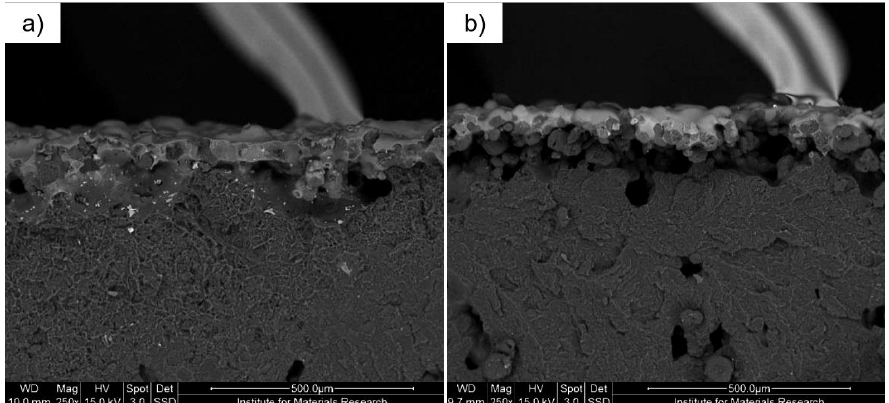
Figure 7. Scanning electron microscope cross-sectional images of a PVDF-coated SLS substrate applied by ( a ) ultrasonic spray coating and ( b ) pneumatic spray coating.